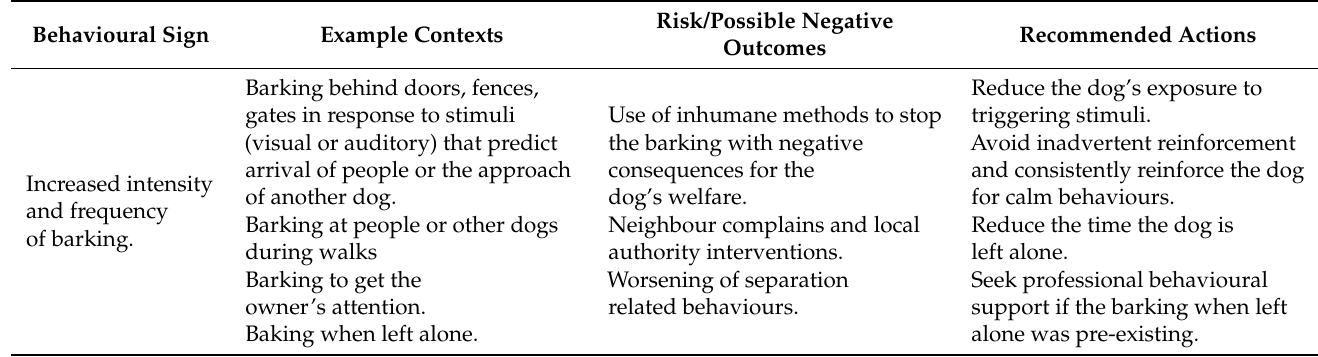
Table 3. Increased barking during corticosteroid treatment as a behavioural sign with examples of possible situations and contexts, possible outcomes and recommended